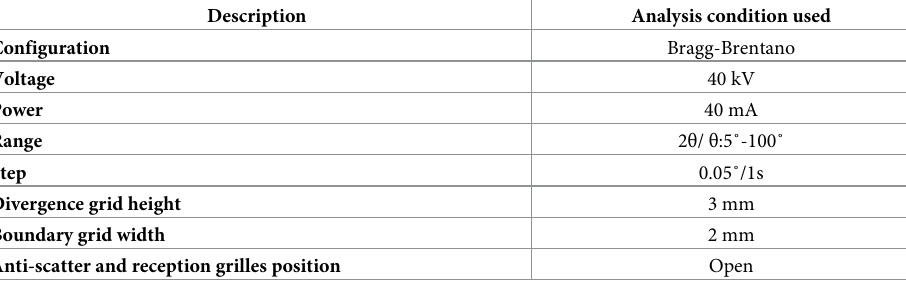
Table 4. Analytical conditions used for XRD